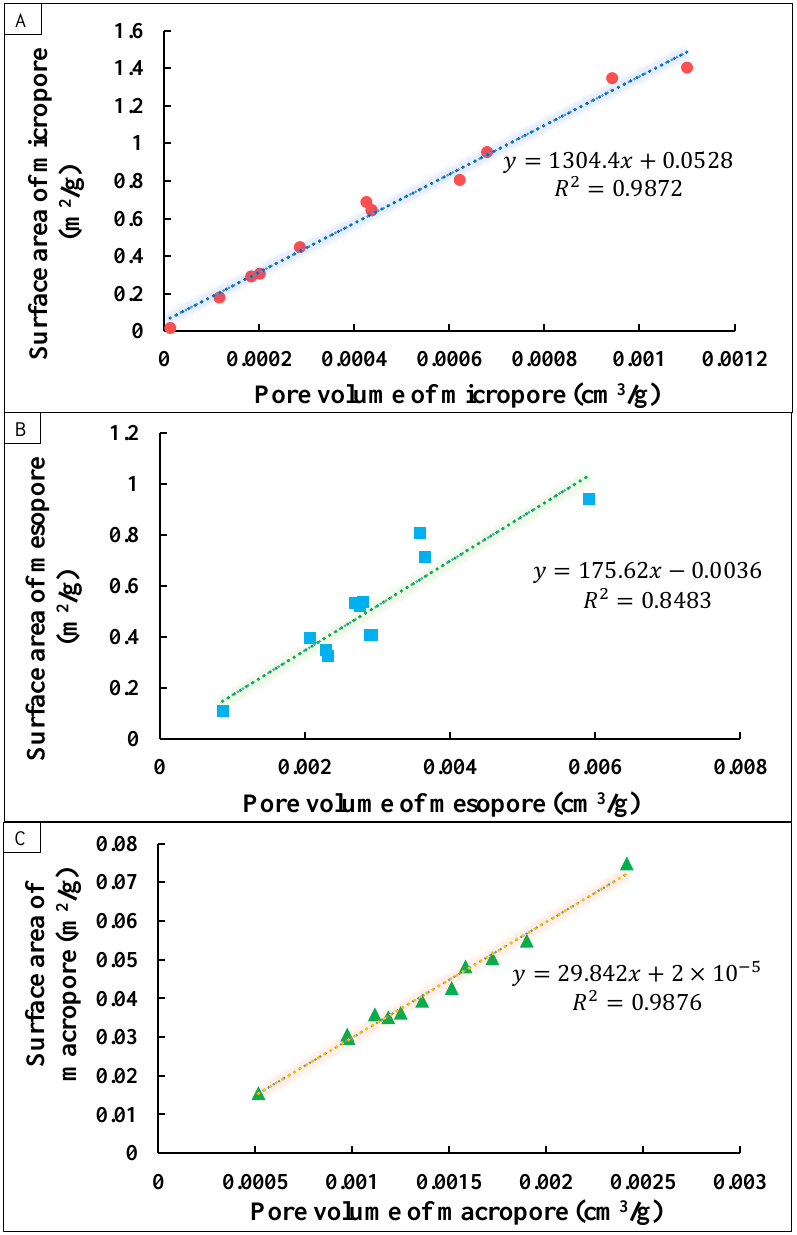
Figure 6. Diagram of the correlations between the pore volume and surface area in different types of pores, as follows:( A ) micropore, ( B ) mesopore, and ( C )